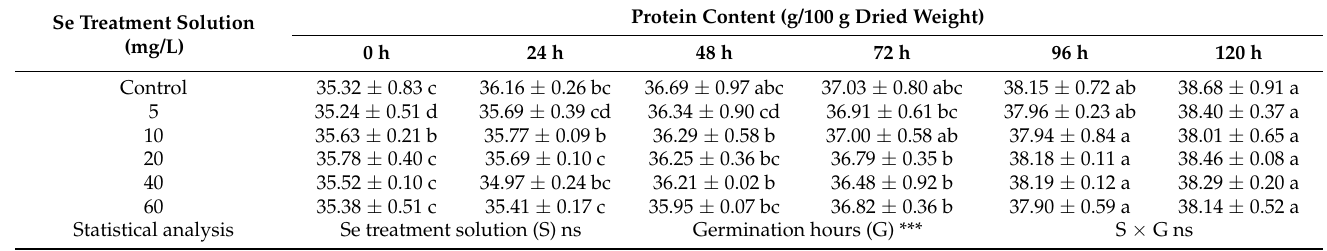
Table 2. Total protein concentration during soybean germination with different concentration Se treatment.